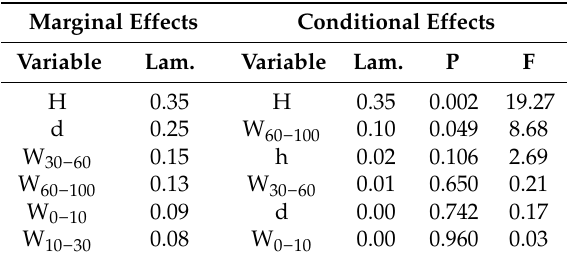
Table 6. Ranking environmental variables in importance in